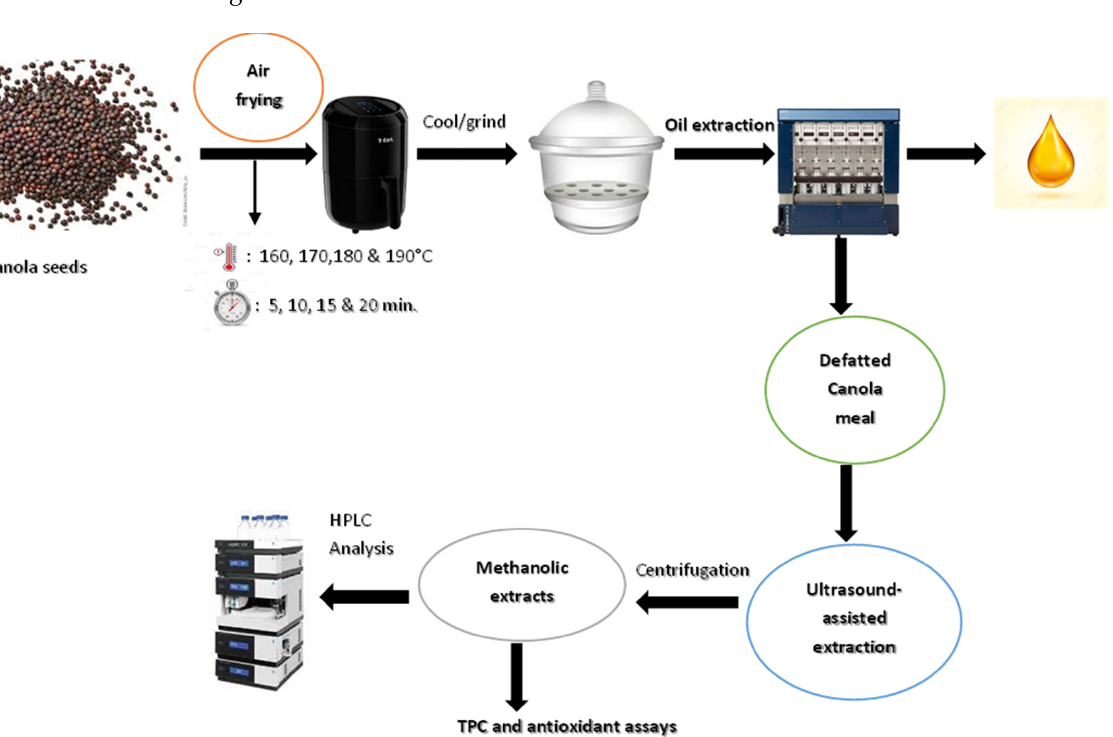
Figure 1. Extraction of phenolic compounds from de-oiled canola meal through air frying pre-treatment and ultrasound-assisted extraction .